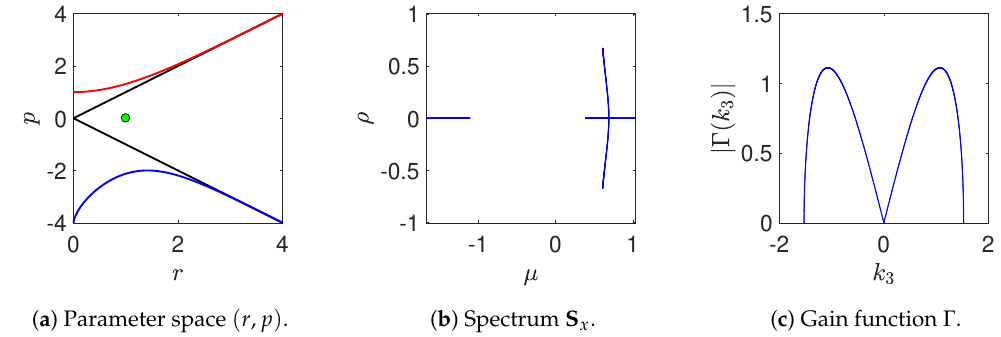
Figure 3. The spectrum S x 1G 1B 0L and gain function Γ for r = 1, p = 0 (mix).